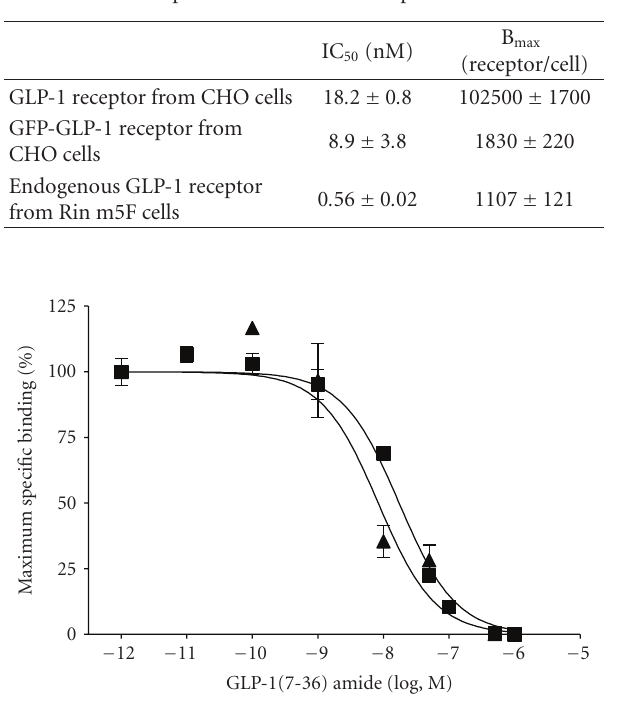
Figure 4: Displacement of [ 125 I] GLP-1(7-36)amide binding to its receptor by GLP-1 from CHO cells. GLP-1 receptor (squares); GFP- GLP-1 receptor (triangles). Each dot with the indicated standard error represents the mean value of three independent experiments done in triplicate (for GLP-1 receptor) and in duplicates (for GFP- GLP-1 receptor). See Results for the details.